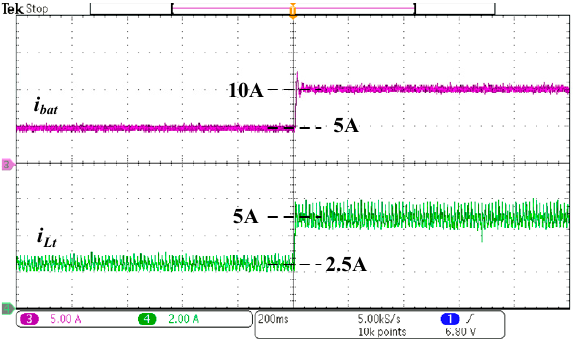
Figure 8. Transient current control waveform of the proposed high-gain RC-BDC.